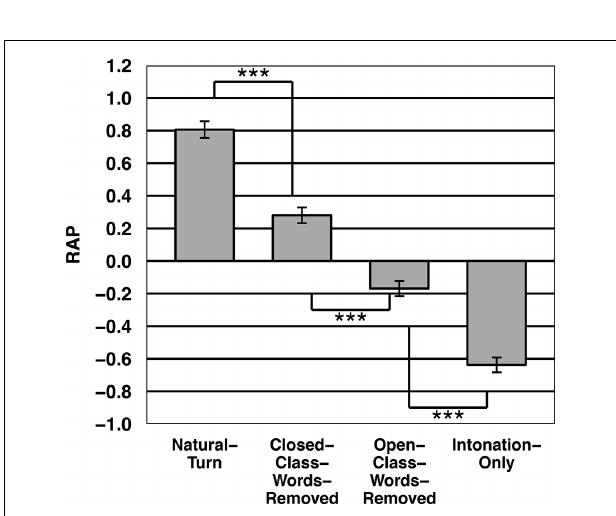
FIGURE 7 | Response distributions per condition from Experiment 3.